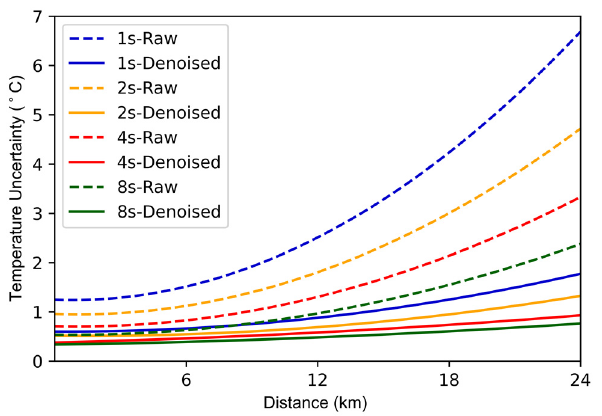
Figure 11. Temperature uncertainty with different spatial resolutions.